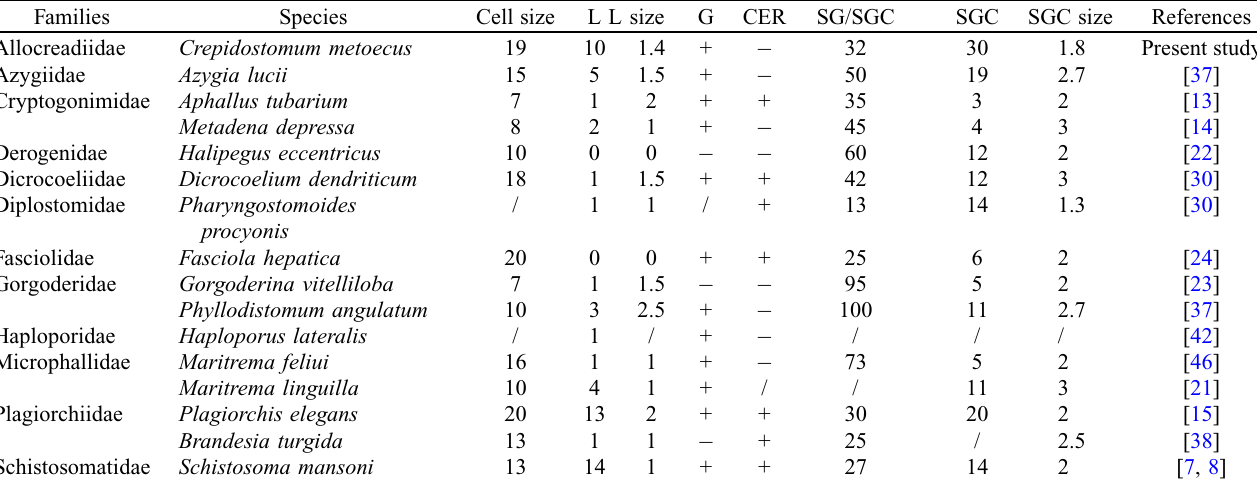
Table 1. Ultrastructural characteristics of mature vitellocytes of Crepidostomum metoecus compared with those of other studied trematodes.